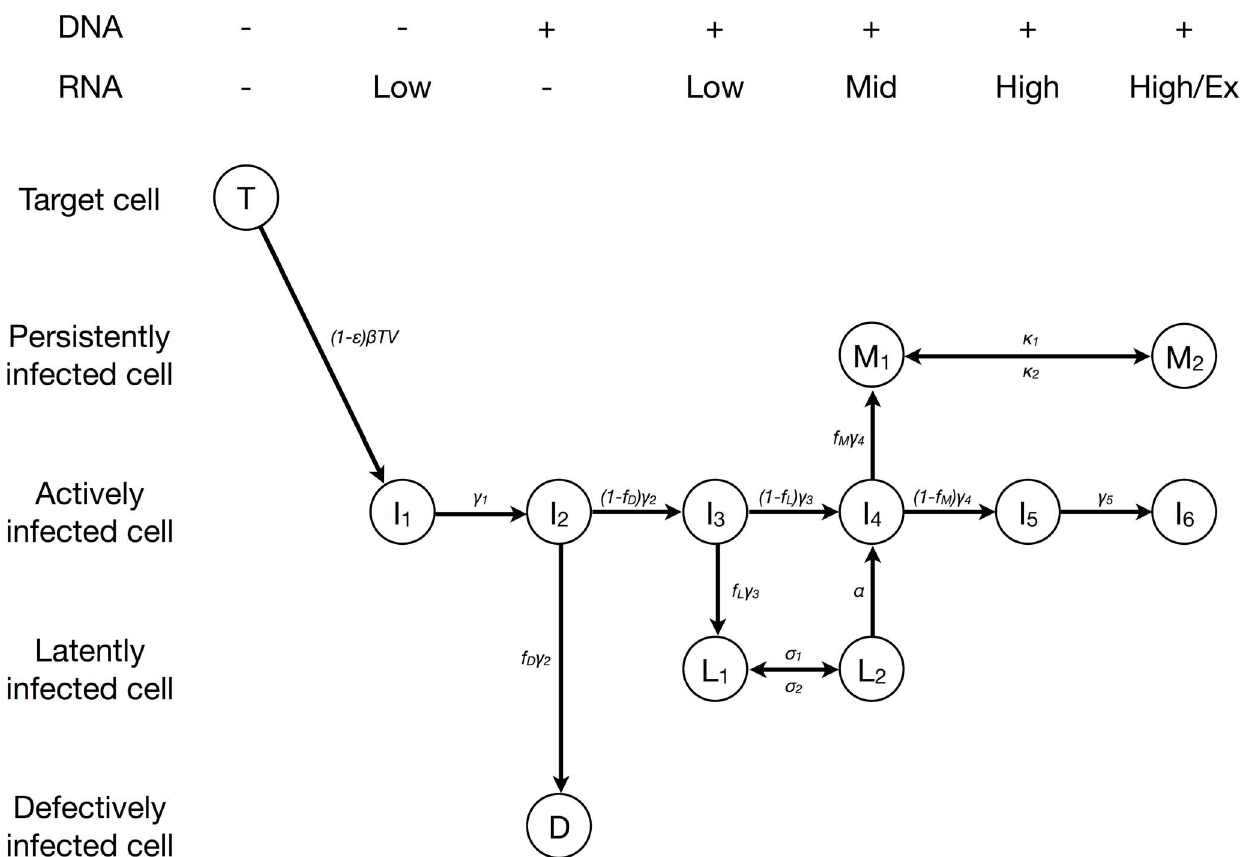
Figure 3. Model of HIV-1 dynamics. Actively infected cells move through an intracellular eclipse phase ( I 1 to I 5 ) before they start to produce virus particles ( I 6 ). Some of the cells during the intracellular eclipse phase become either defectively infected ( D ), latently infected ( L 1 ) or persistently infected ( M 1 ). Both latently ( L 1 and L 2 ) and persistently ( M 1 and M 2 ) can move between two transcriptional states. Persistently infected cells that are in a high transcriptional state ( M 2 ) also contribute to virus production. The different subpopulations of infected cells can be stratified according to their HIV-1 DNA and RNA content (shown on top).